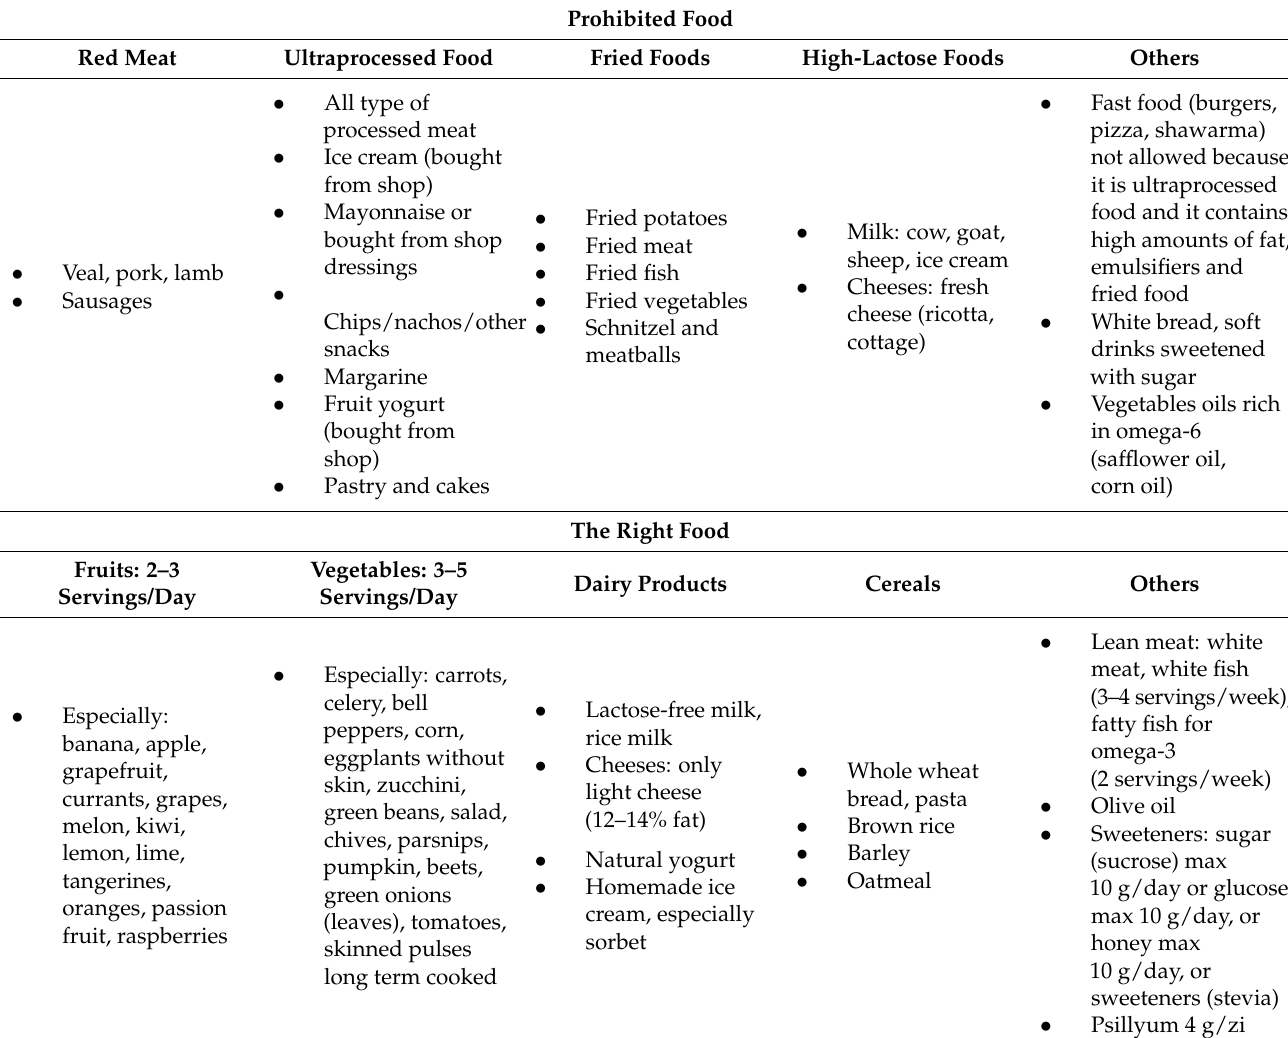
Table 1. The exclusion diet for IBD in the intervention